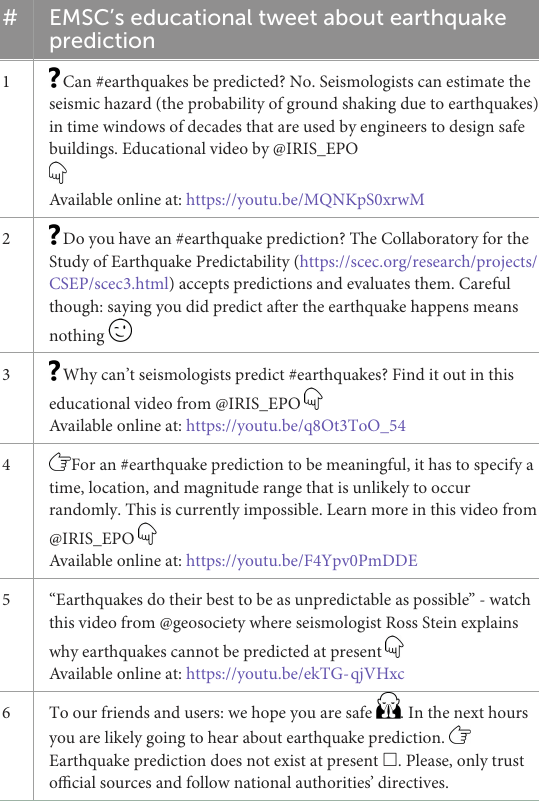
TABLE 1 EMSC’s educational tweets about earthquake prediction. # EMSC’s educational tweet about earthquake